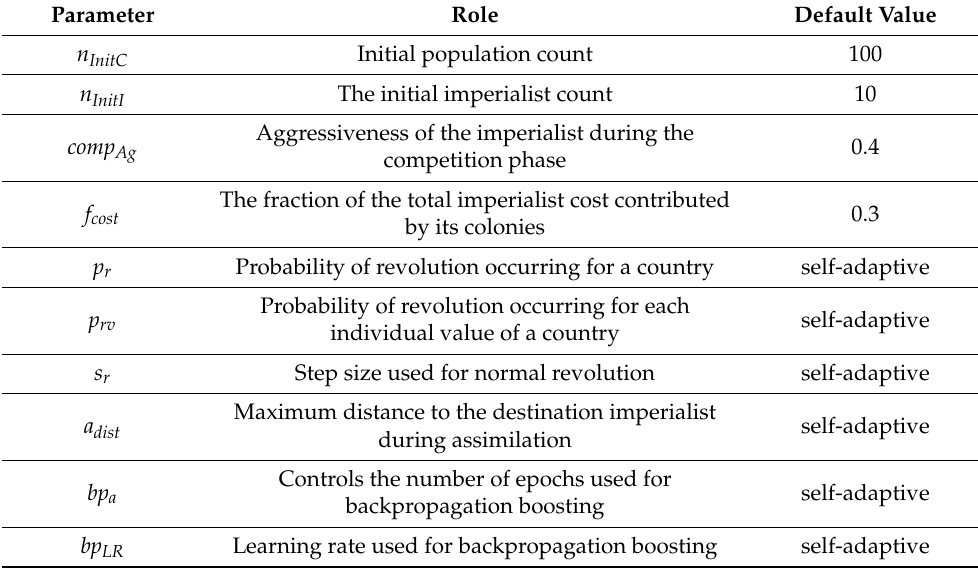
Table 1. The parameters of our algorithm, their values, and their role within the algorithm’s iterations. The value “self-adaptive” refers to the fact that the values of the corresponding parameters were optimized by the algorithm itself via the self-adaptive control